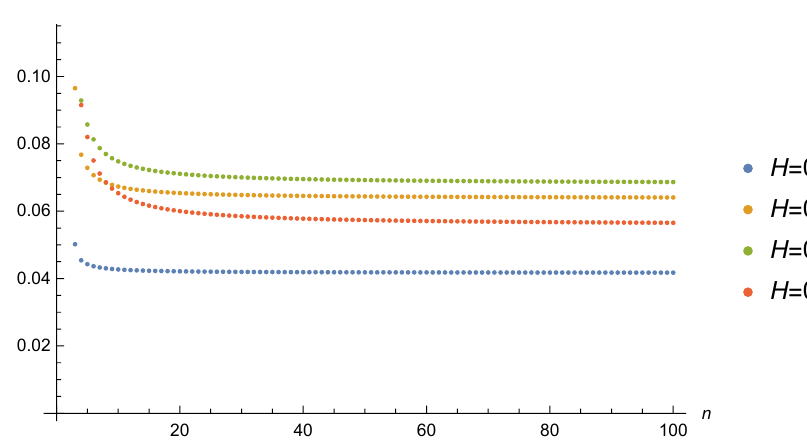
Figure 7. Case k = 2: Γ 2 n as the functions of n .